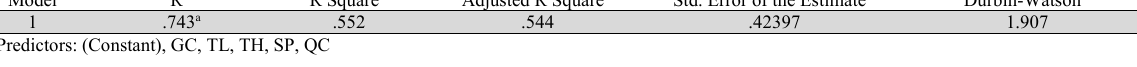
Verify the model's interpretation level